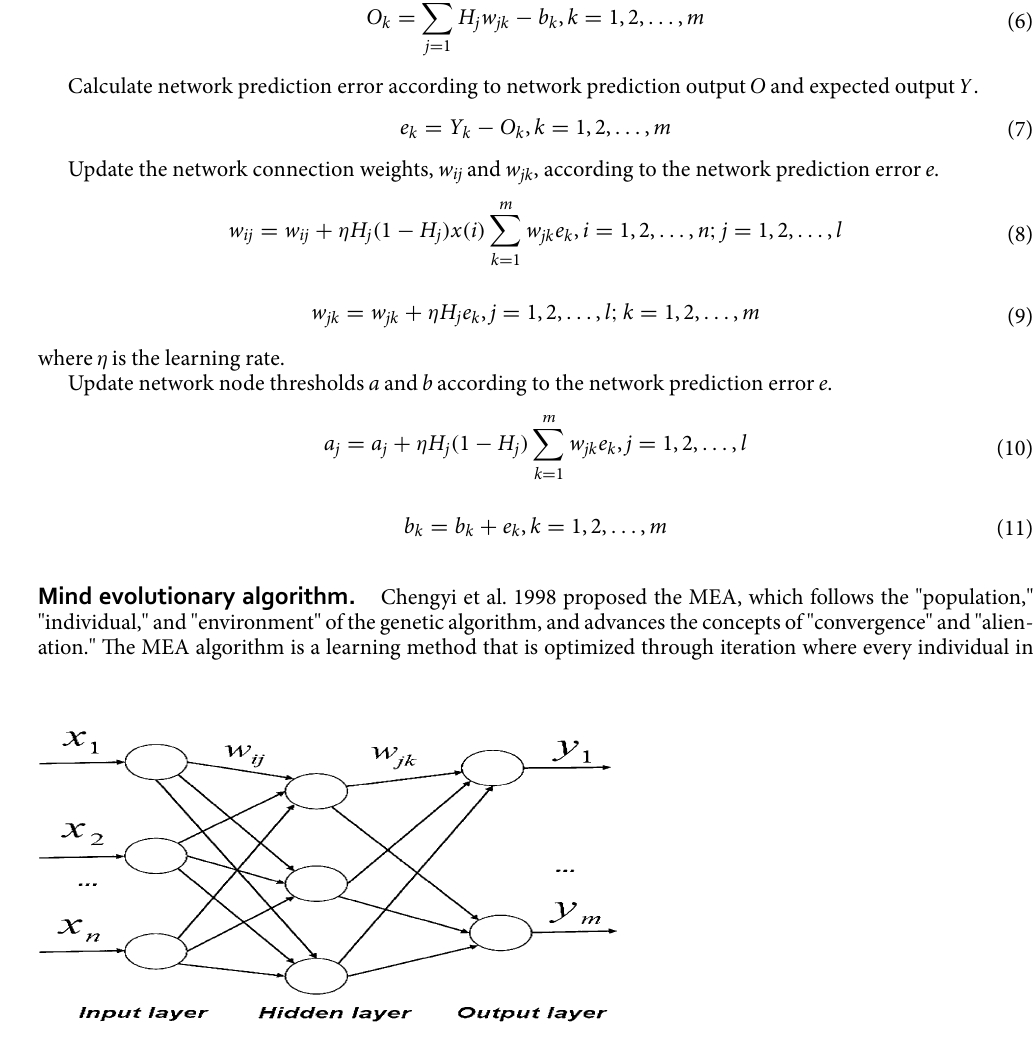
Figure 1. BP neural network topology structure